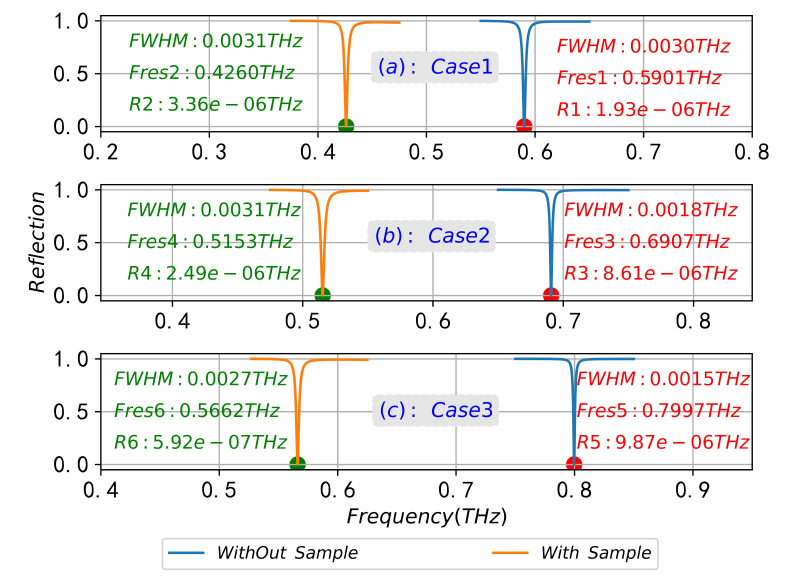
Figure 14. SPR reflection spectrum corresponding to the di ff erent resonant structures (Case1, Case2 and Case3) without sample ( a ) in Table 4 and with sample ( b ) in Table